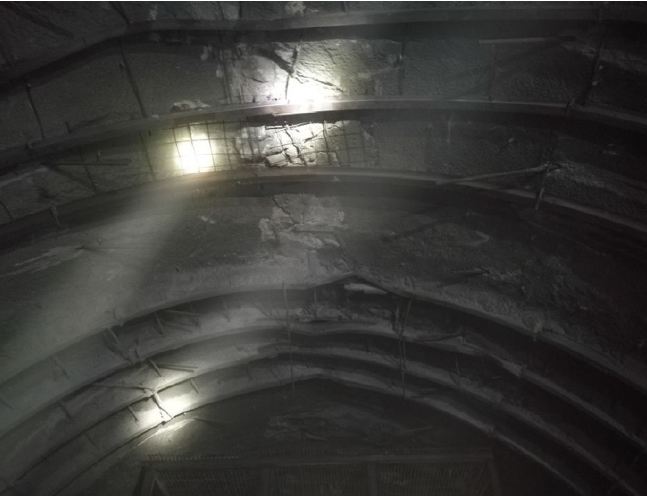
Figure 11. The twisted steel arch and back haunch fillet of the arch, and rockfall of the initial support.